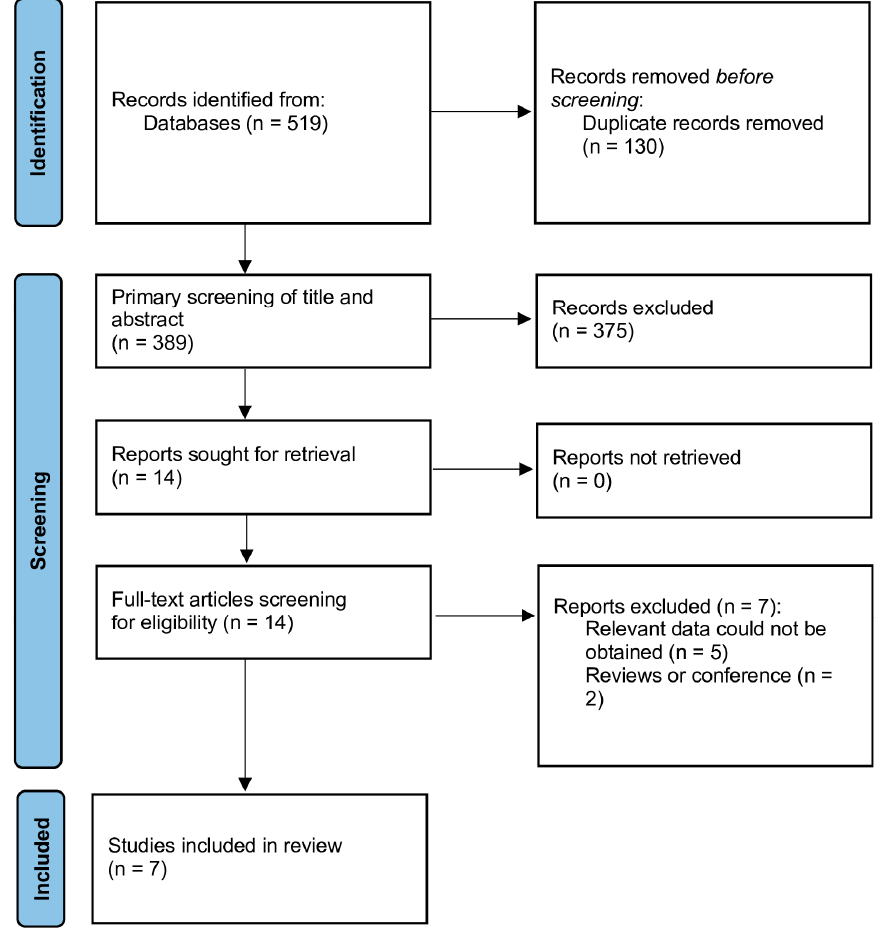
Figure 1. PRISMA flow diagram of the study selection process. Table 1. Characteristics of included trials.